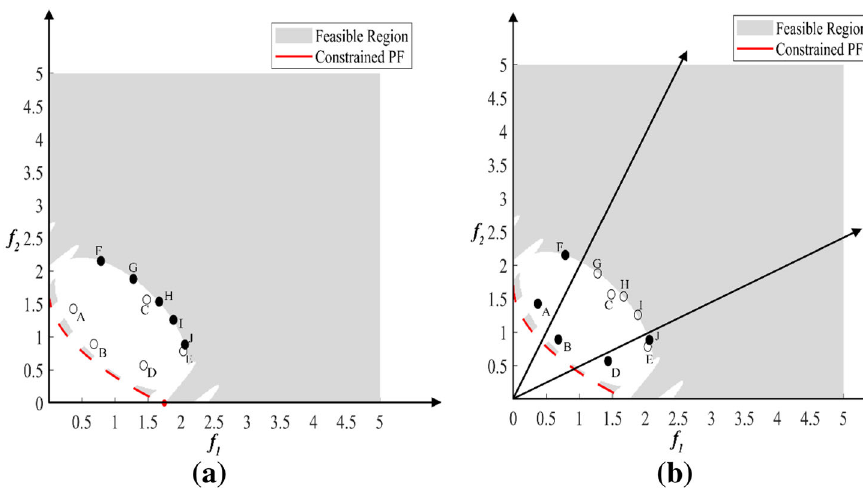
Fig. 4 Hypothetical distributions of ten candidate solutions A–J on LIR-CMOP10, the black dots in a and b are the best five solutions selected by CDP and EGDCMO,